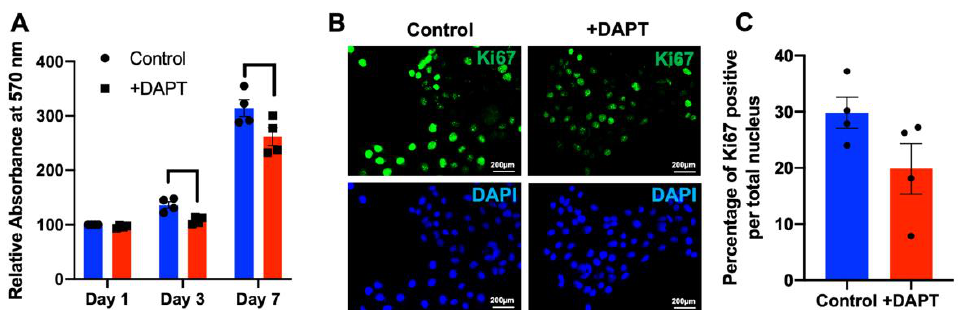
Figure 4. DAPT attenuated HSC-4 cell proliferation. Cells were treated with DAPT ( n = 4). DMSO was used as the vehicle control. ( A ) Cell proliferation was determined using an MTT assay. ( B,C ) Ki67 protein expression was examined using immunofluorescence staining. Bars indicate a significant difference between groups ( p < 0.05).